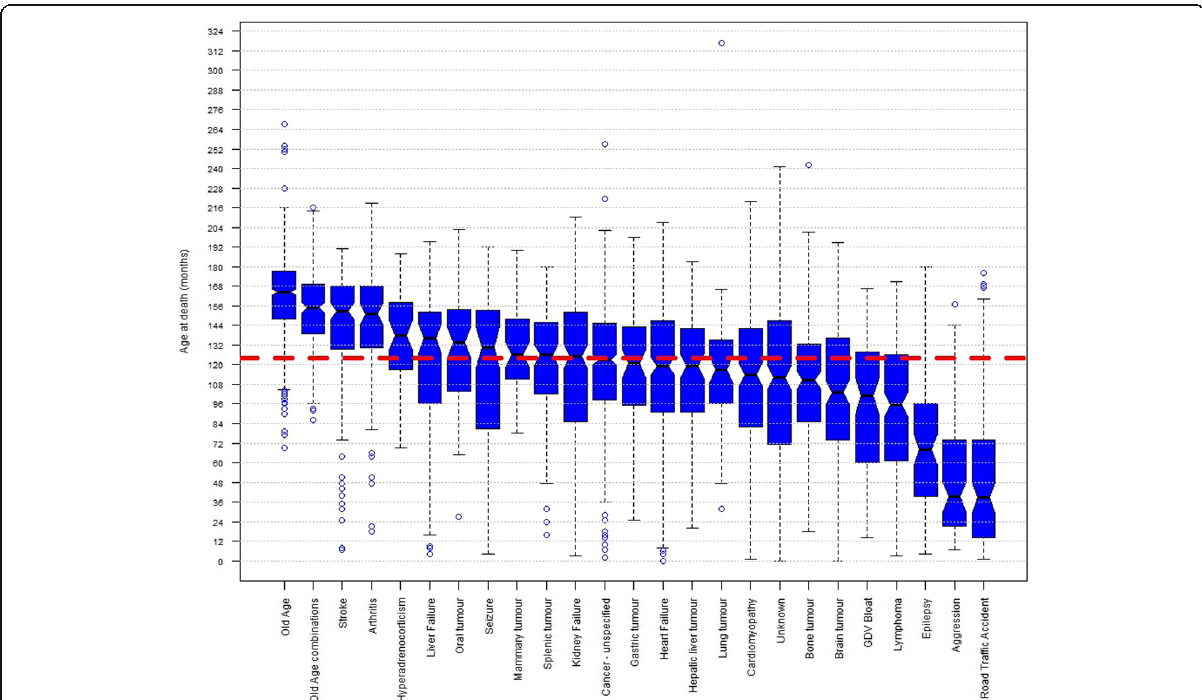
Fig. 4 Box and Whisker plot of age at death across common causes of death. Notched Box and Whisker plot of age at death (months) for the 25 causes of death with ≥ 50 deaths reported. ‘ Notches ’ in the boxes indicate the approximate 95% confidence interval of the median. The red dashed line indicates the median age at death of all dogs in the survey (n = 5663) of 124 months, and the thickness of this line approximates to the 95% confidence interval (122.57 to 125.43